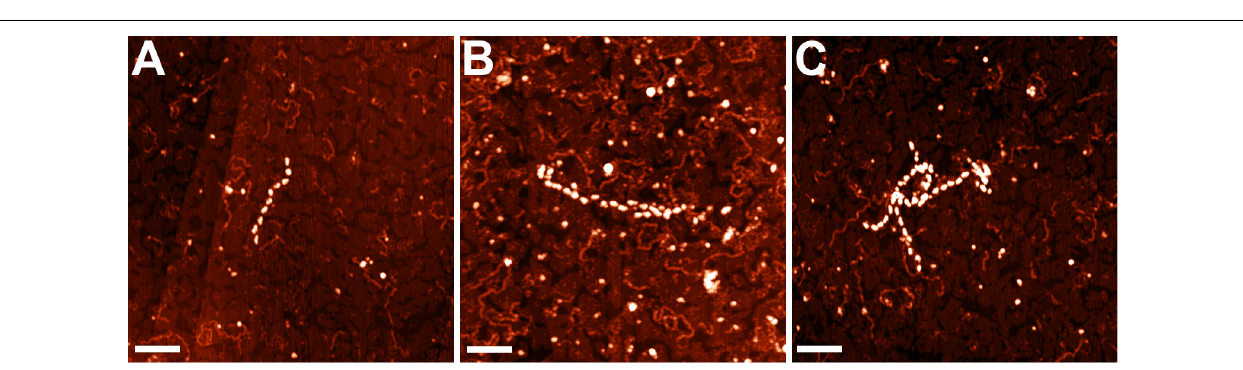
FIGURE 2 | AFM images of the structures (A–C) , observed only in the stationary phase nucleoids of M. gallisepticum . Bar = 100